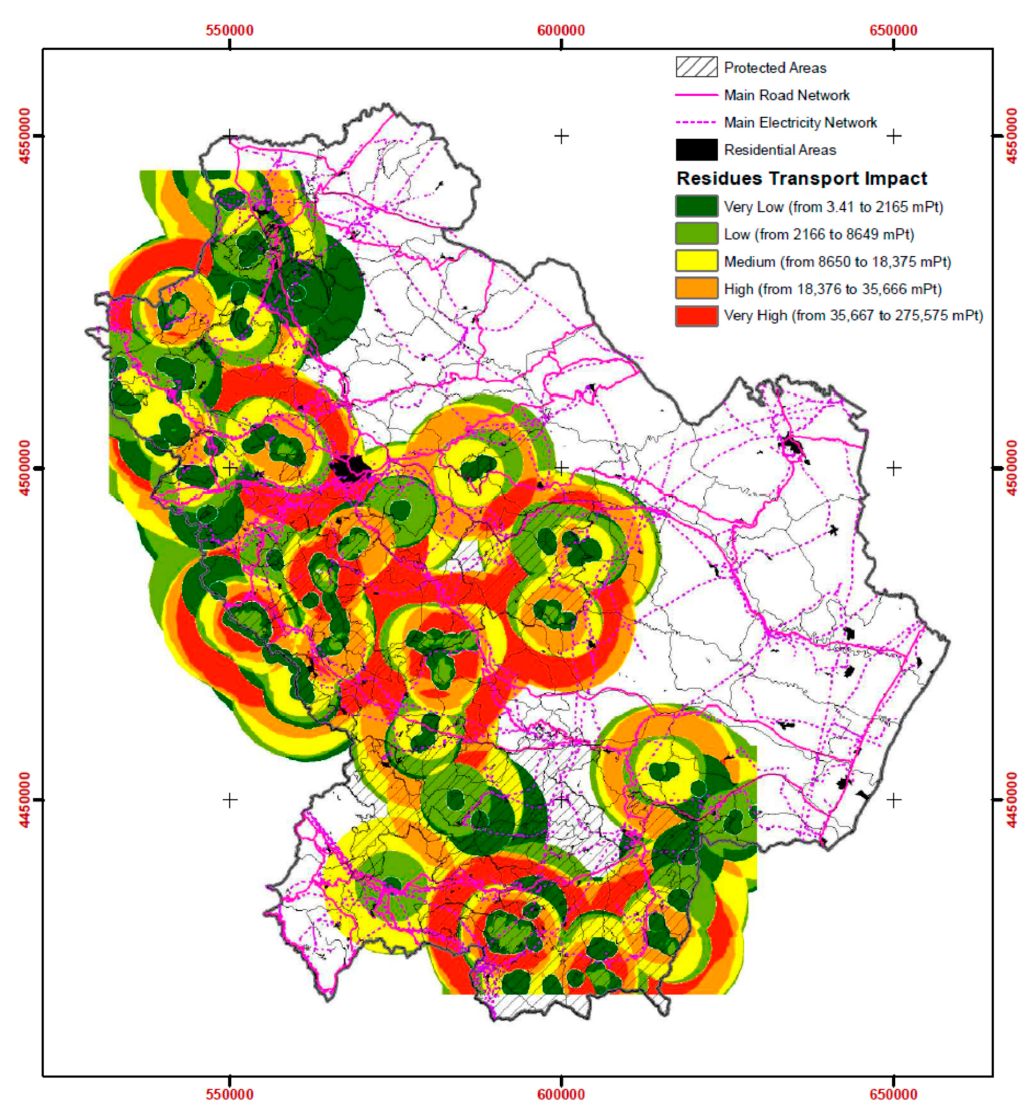
Figure 3. Territorial distribution of harvesting residues transport impacts.